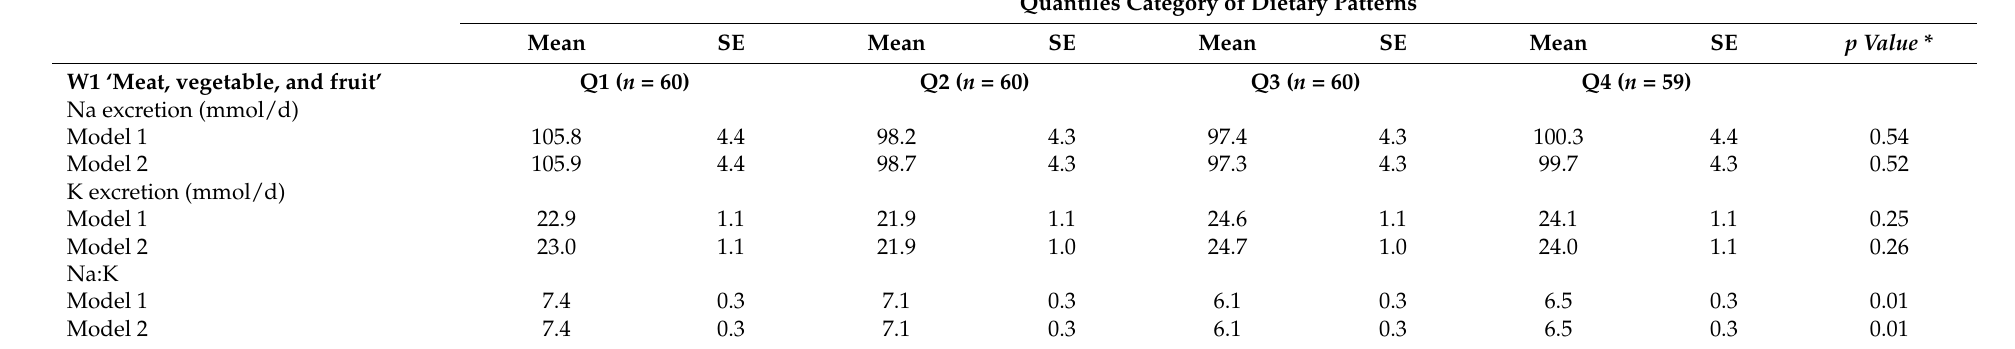
Table 4. Multivariate-adjusted means and SE for urinary sodium and potassium excretion and sodium:potassium ratio by quintile of each dietary pattern for 239 Indonesian